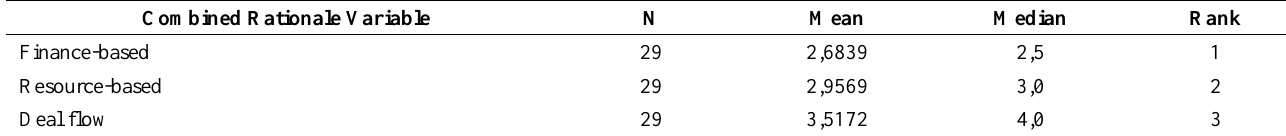
Table 6: Measures of central location for the non-syndication composite rationale variables